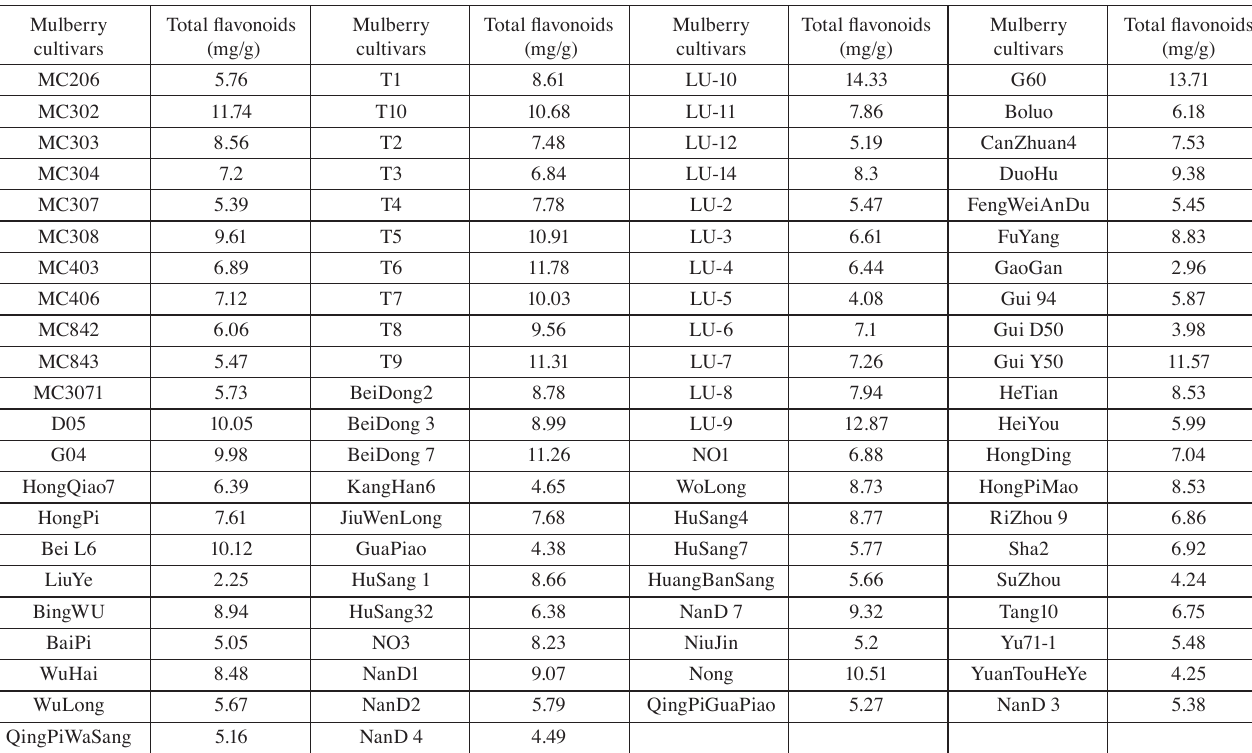
Fig. 2: The content of total flavonoids at different leaf positions 1-10: from apical to basal of the branch